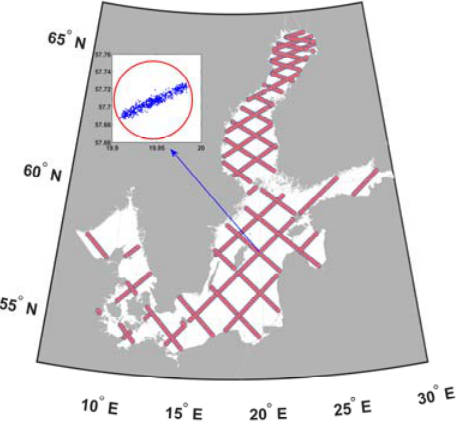
Figure 2 . Search circles with the radius of 3km and the SSH observations within each circle that is associated to the central point of the circle to generate the point-wise time series of SSH at every 6km along the satellite's ground tracks over the Baltic Sea.